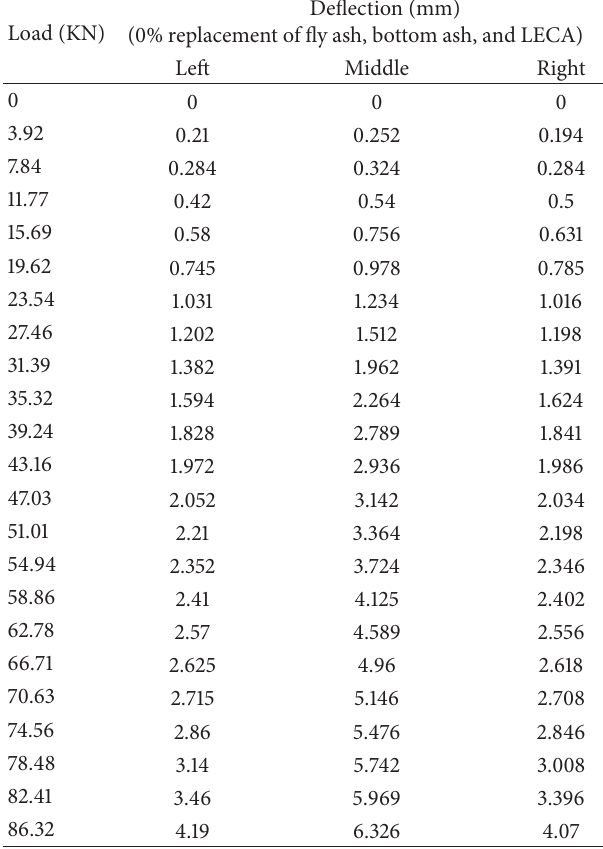
Table 4: Load versus deflection of control